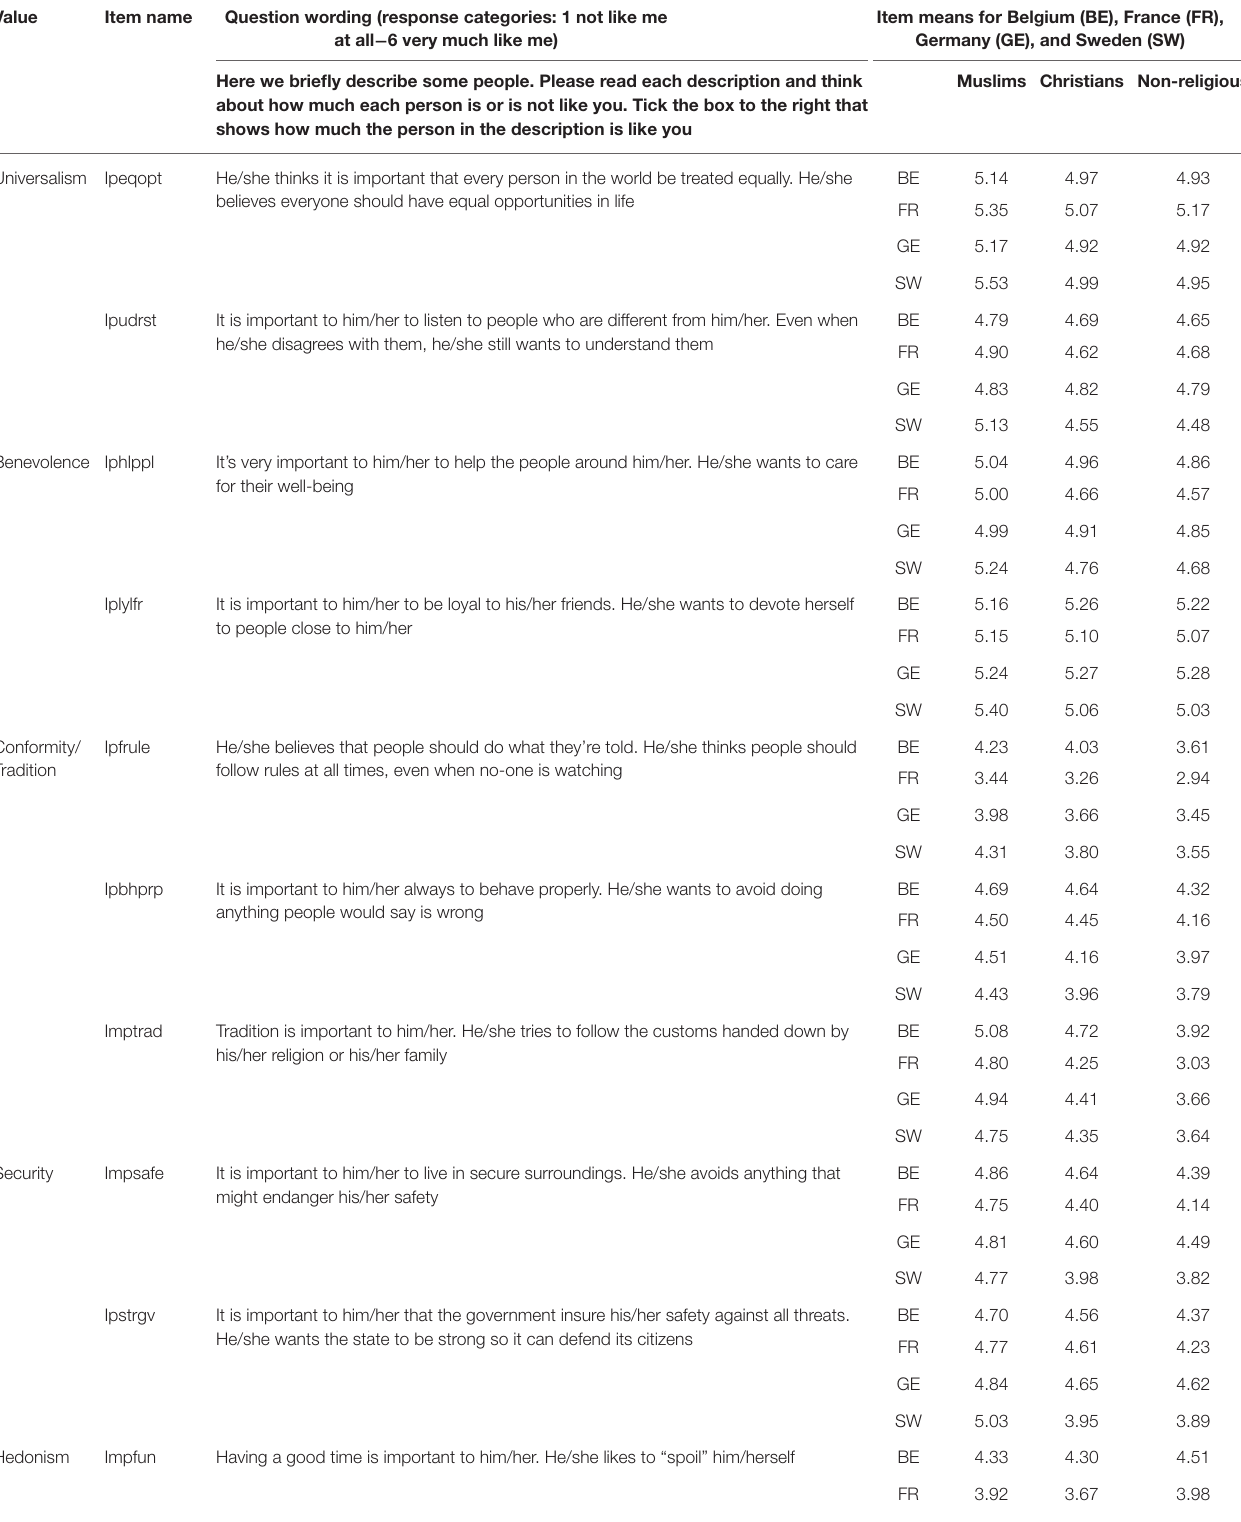
TABLE 3 | Means for the value measuring items for Belgium, France, Germany, and